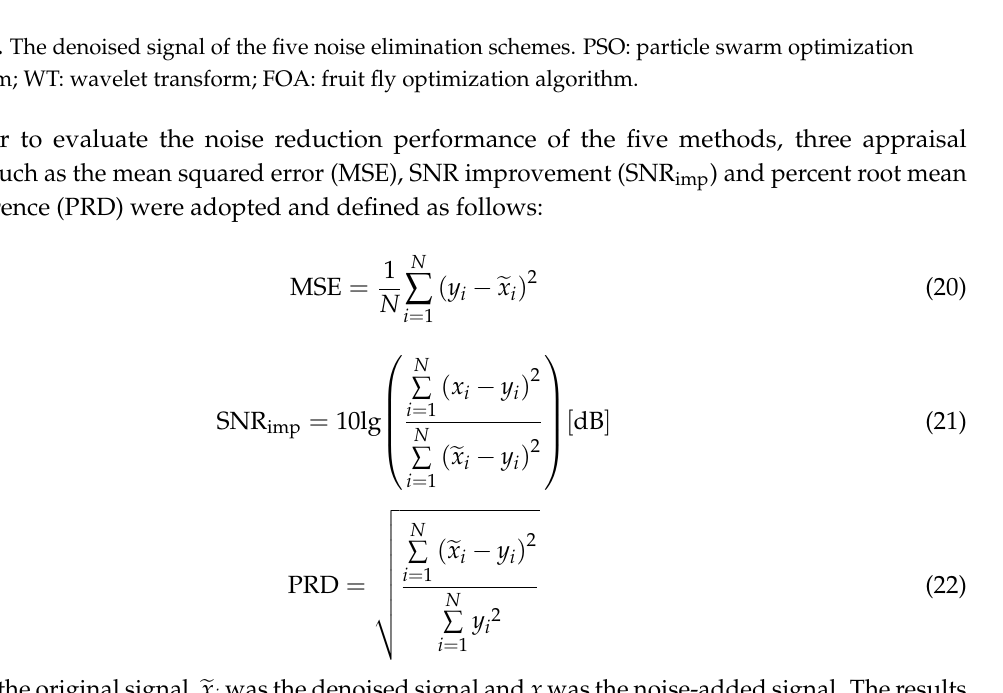
Table 1. The denoising performance of the five methods (with SNR = 5 dB). SNR: signal-to-noise